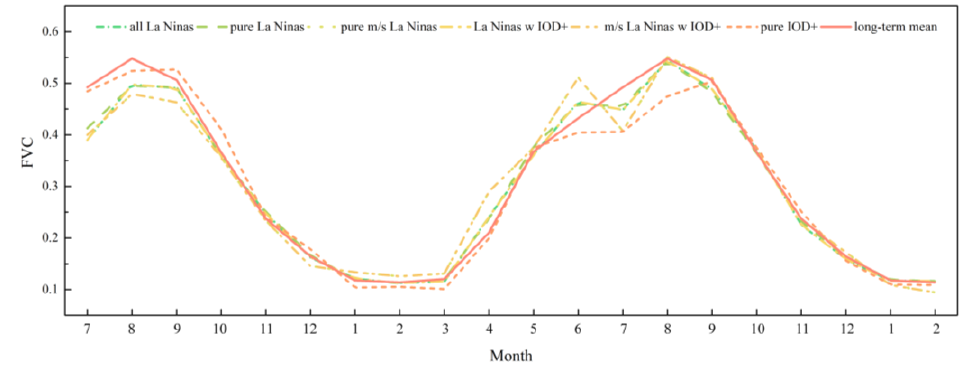
Figure 14. Average FVC value during La Nina/IOD+ periods from 2000 to 2019 in Qingyang city.